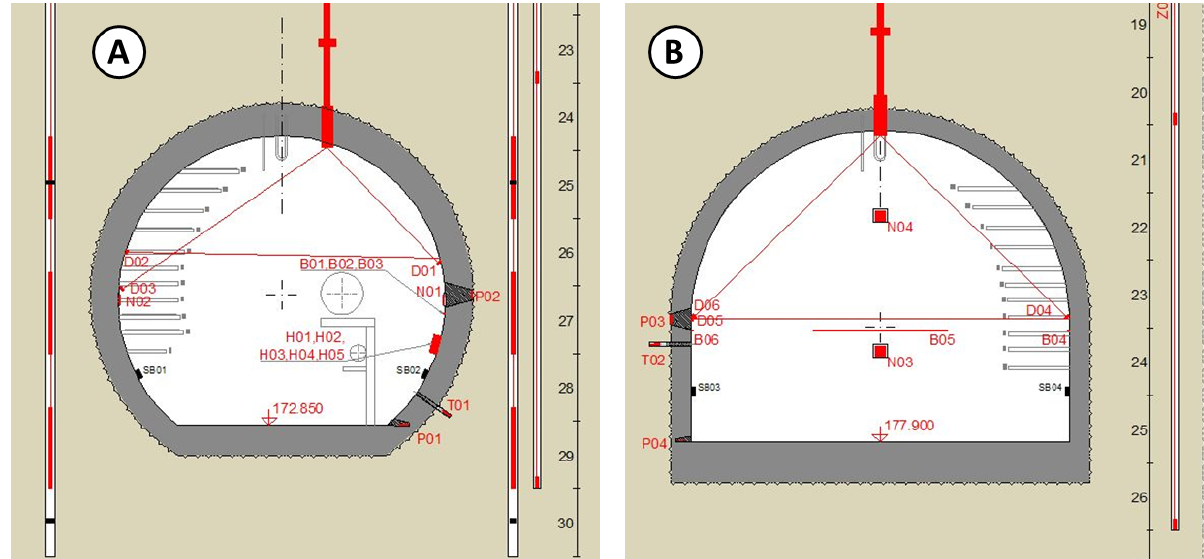
Figure 2. Cross section of the utility tunnel; Left – in soft soil conditions; Right – in hard rock conditions [4].